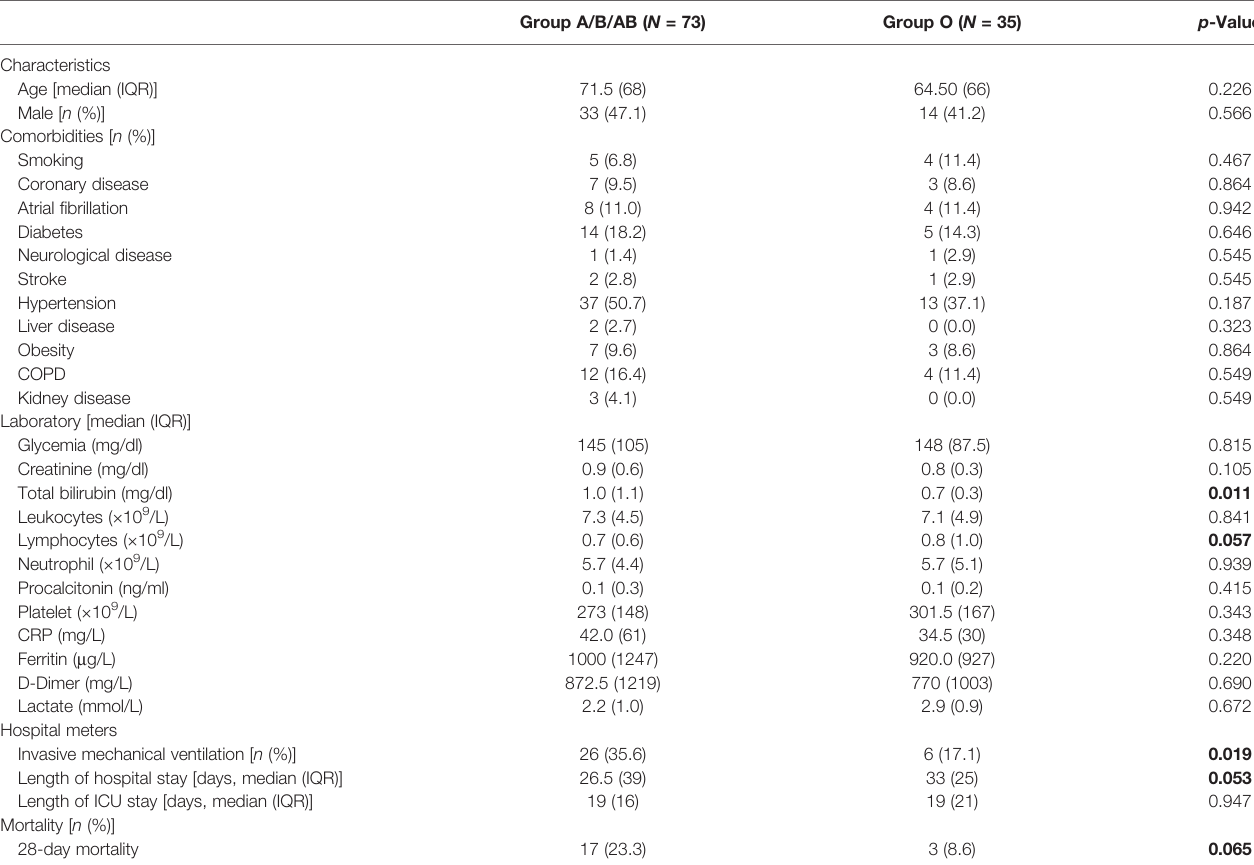
TABLE 1 | Clinical characteristics of the patients.